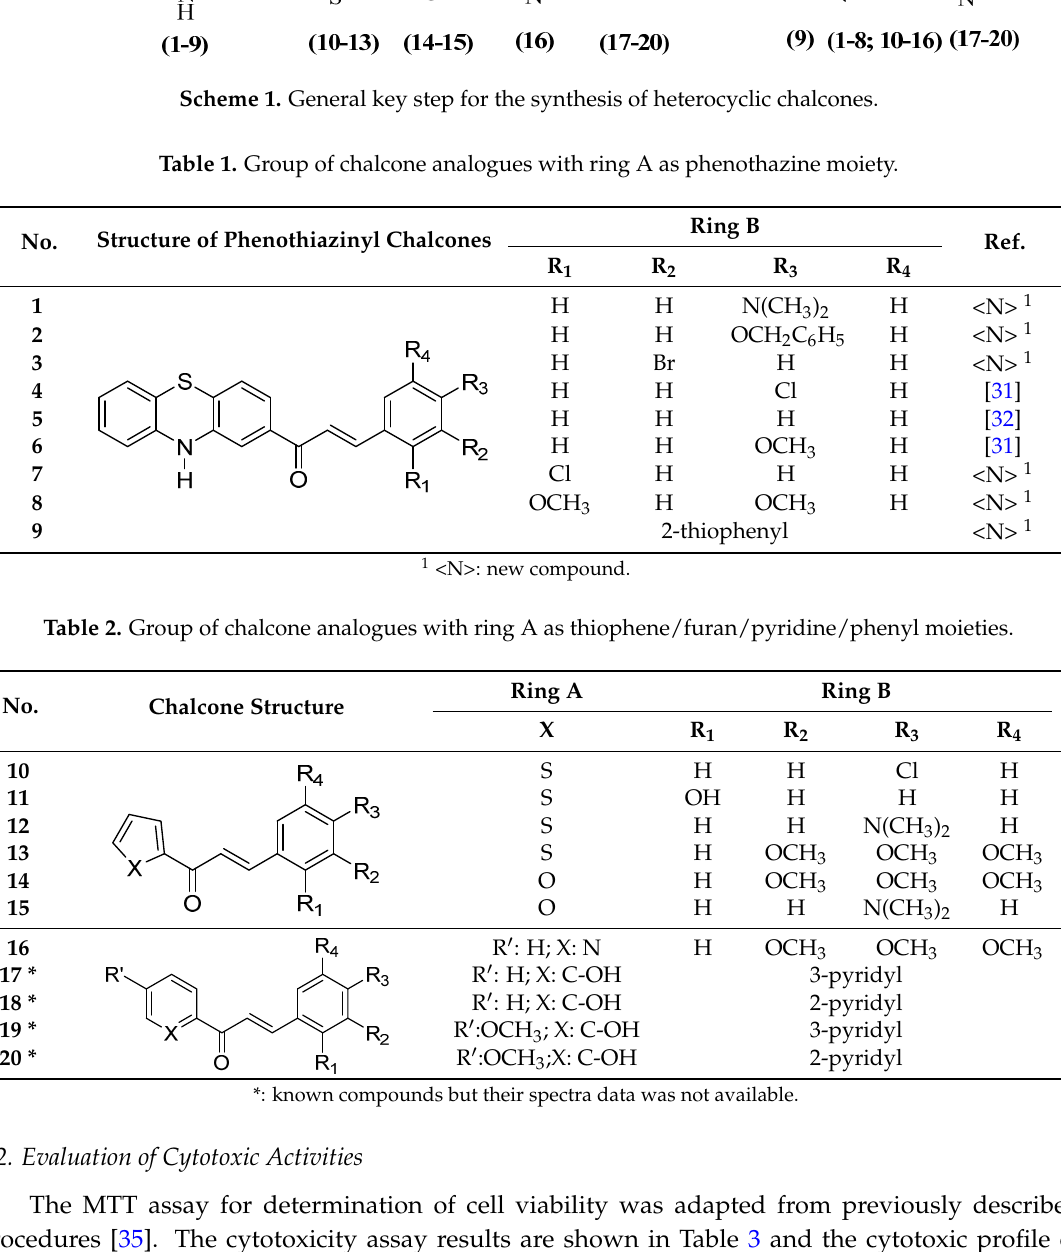
Table 3. Cytotoxic profile of the potent synthesized heterocyclic chalcones on RMS cells. values below 20 µ M. These results are in accordance with reported intitial structure-activity relationship of anticancer chalcones, i.e. , heteroaryl moieties either on ring A or ring B of chalcones provide cytotoxicity on cancer cells [30]. More interestingly, compounds 7 , 8 , 9 and 16 show an almost complete absence of toxicity on the noncancerous LLC-PK1 cell